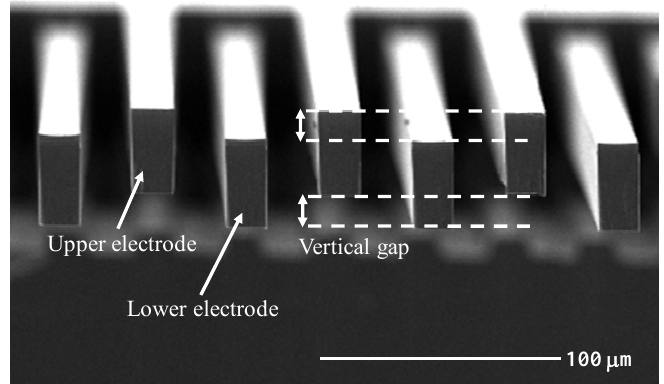
Figure 12. Test pattern fabricated using the ESBM